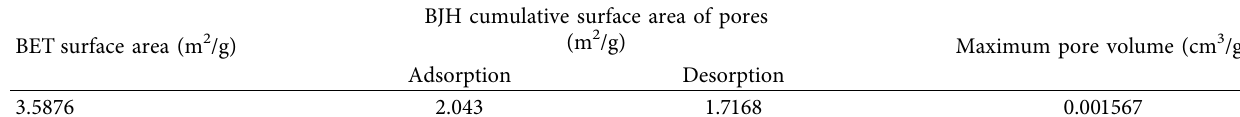
Figure 2: N 2 adsorption-desorption isotherm (a) and the pore size distribution (b) of fly Table 3: Surface area and pore properties of the fly ash.